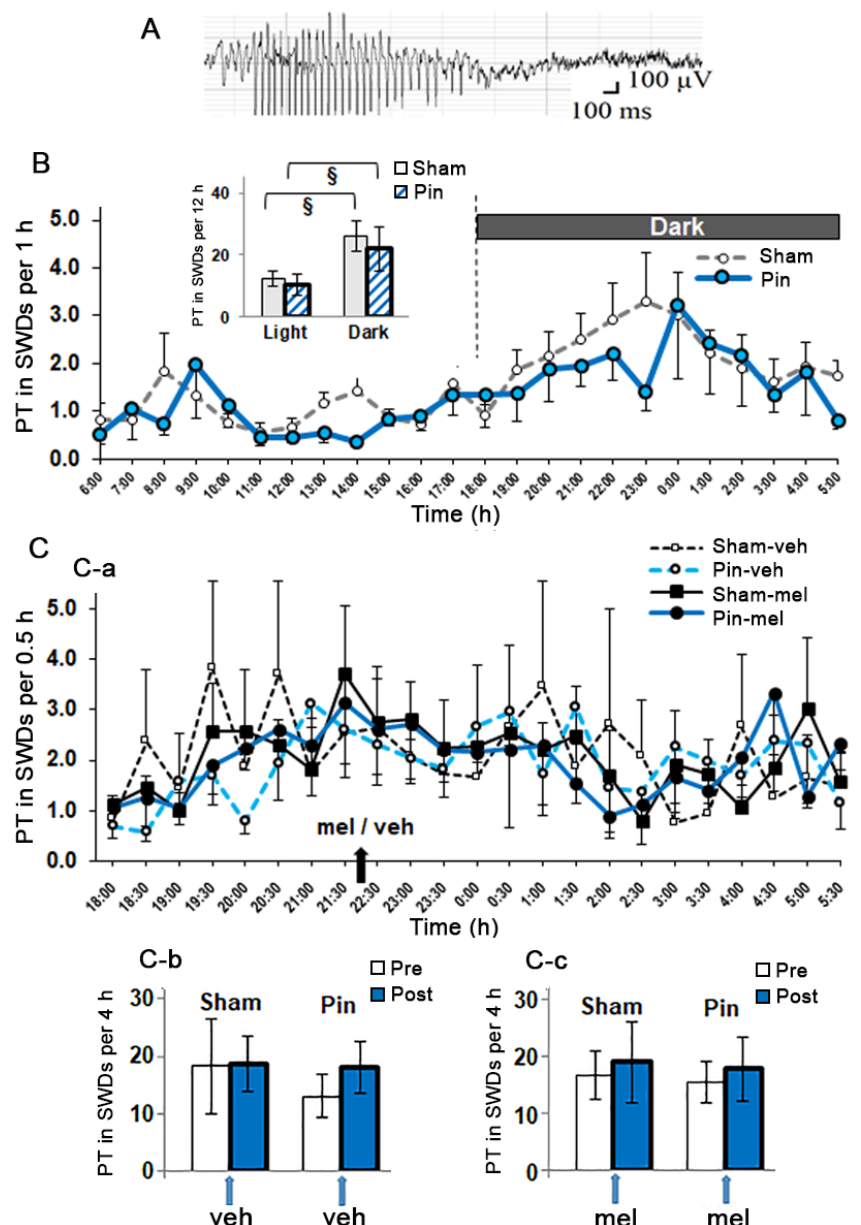
Figure 1. Effects of pinealectomy and melatonin treatment on SWDs in Wistar Albino Glaxo from Rijswijk (WAG/Rij) rats. Representative SWD and PT in SWDs per hour of recording from 6:00 a.m. (light on) to 6:00 p.m. (light off) in Sham and pinealectomized (Pin) WAG/Rij rats are shown in ( A , B ), respectively. Total PT in SWDs during the entire light and dark phases is shown in the inset. (§) — Significant difference between light and dark phases for both Pin and Sham rats [2-way ANOVA and post-hoc Fisher least-significant difference (LSD) test, p < 0.05]. The effects of treatment with melatonin (80 mg·kg −1 s.c.) and vehicle in Sham and Pin rats on PT in SWDs are shown in ( C ). Injections were performed at 10:00 p.m. (arrow in ( C-a )). SWDs were counted from the second 30-min period after injections to minimize the effect of stress on the incidence of SWDs. Total PTs in SWDs in the 4 h preceding and following vehicle or melatonin treatments in Sham and Pin rats are shown in ( C-b ) and ( C-c ), respectively. Values are means ± S.E.M.